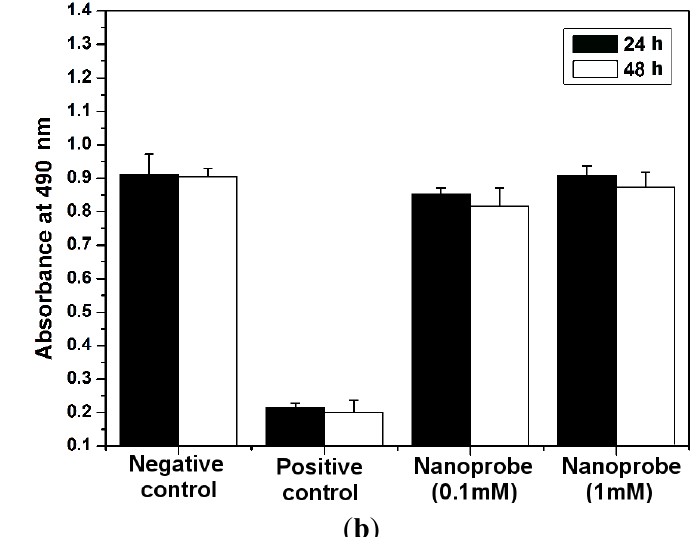
Figure 2. The in vitro biocompatibility of the dual-modality nanoprobes. ( a ) Cell uptake